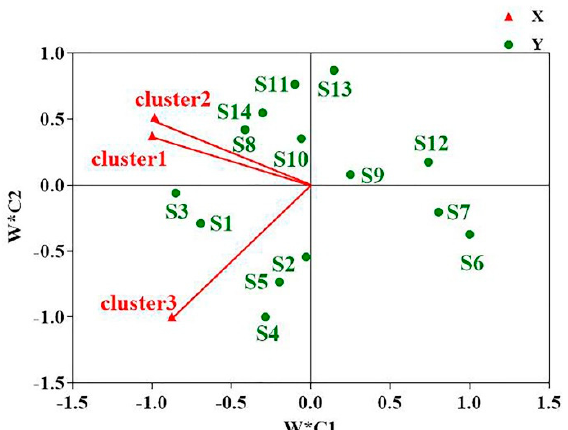
Figure 6. External preference mapping based on results of principal component analysis and ag- glomerative hierarchical clustering analysis. Cluster1, cluster2, and cluster3 refer to the three clus- ter groups formed based on K-means clustering analysis of preference, respectively.